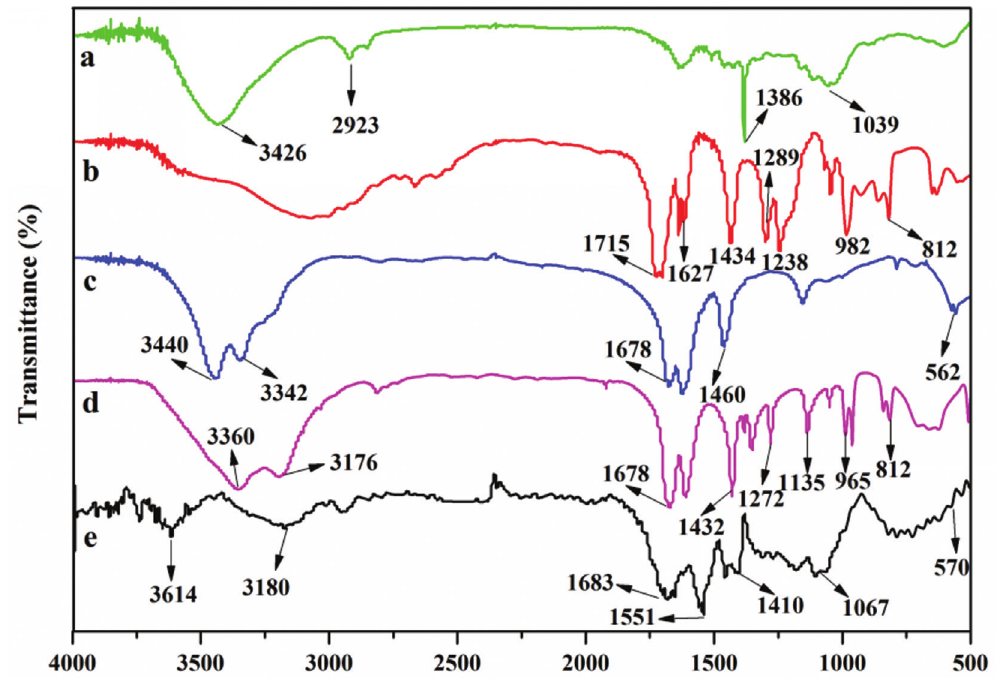
Figure 1: FTIR spectra of SC (a), AA (b), urea (c), AM (d) and SC-g-PAA/PAM/Urea